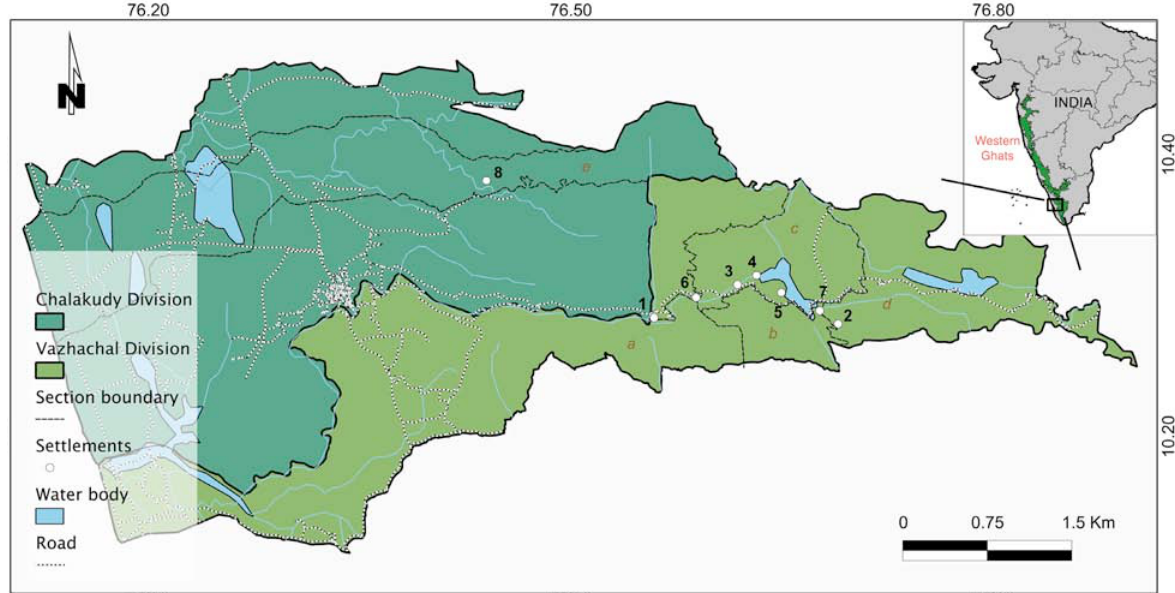
Figure 1. Map of the study area and the surveyed human settlements and forest ranges (see Appendix 1) in the Western